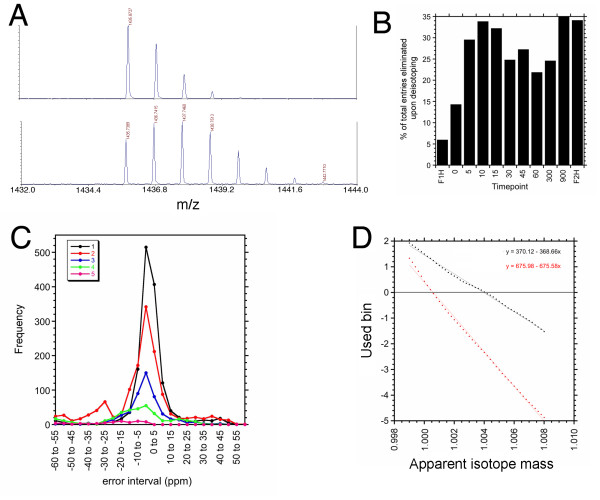
Deisotopingof peptide-clusters. (a) m/z 1425 peptide in MALDI-TOF spectra from two samples: Upper – F1H (fully 1H; instrument-deisotoped). Lower – after deuteration (incompletely instrument-deisotoped) (b) Count of discarded isotope masses in the timepoints from a typical deuterium exchange experiment. F1H and F2H are fully protic and fully deuteric, respectively, other times are in sec. F1H isotope discovery rate was typically 1% that of F2H (data now shown). The discovery of some isotopes in F1H could be attributed to the occasional occurrence of perfectly coincident fully protic peptides, upsetting the deisotoping algorithm in the AB 4700 mass spectrometer software, or closely apposed spectra to within fractional mass. (c) Histogram (line display format) showing distribution of isotope mass errors among the 3670 total isotopes detected with isotope mass error tolerance set to +/- 60 ppm, deisotoping gradient factors = 0 (no incremental widening of tolerance per isotope increment). Number of "rungs" (isotope increments) </= 5. From this histogram, +/- 12 ppm was chosen as the default deisotoping mass tolerance, with positive and negative gradient factors both set to 1 (one doubling of mass tol per additional isotope) and five rungs max. In a random sample dataset, TOF2H picked 183 out of the 189 isotopic peaks that were identified by eye, ie a correct hit rate of 96.8% (3.2% false negative). (d) Determination of an isotope mass difference that nulls the distribution in (c). In each of the two experiments, a series of test isotope masses (panel c, all rungs combined) was tested followed by calculation of the weighted mean bin-point (y) of the resulting histograms and linear regression of each series. The optimal inter-isotope mass for each experiment is the value of x where y = 0.